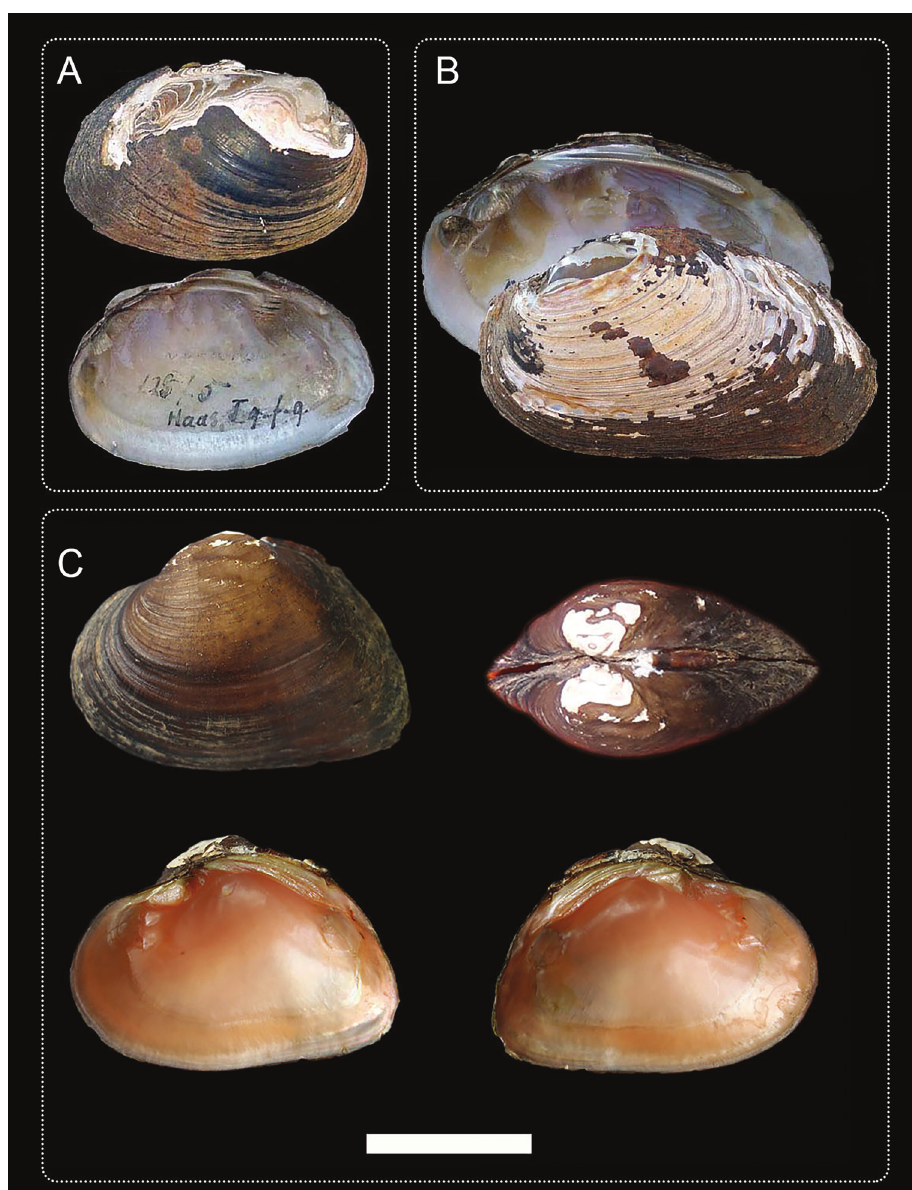
Figure 1. Photographs of Inversidens taxa A I. brandtii B I. pantoensis C I. rentianensis sp. nov. Photos: [ A, B ] from the MUSSEL Project, [ C ] from this study, NCFM180325 (holotype), scale is 2 cm.